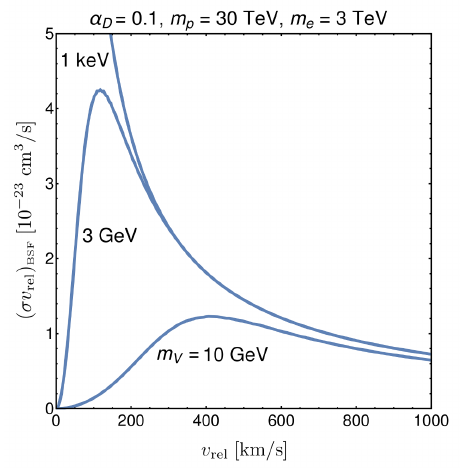
Figure 2: The bound state formation cross section for different choices of dark photon mass. The scaling of the cross section changes from approximately ( σ v ) ∝ 1 / v ∼ m /µ to ( σ v at v D rel rel rel V BSF